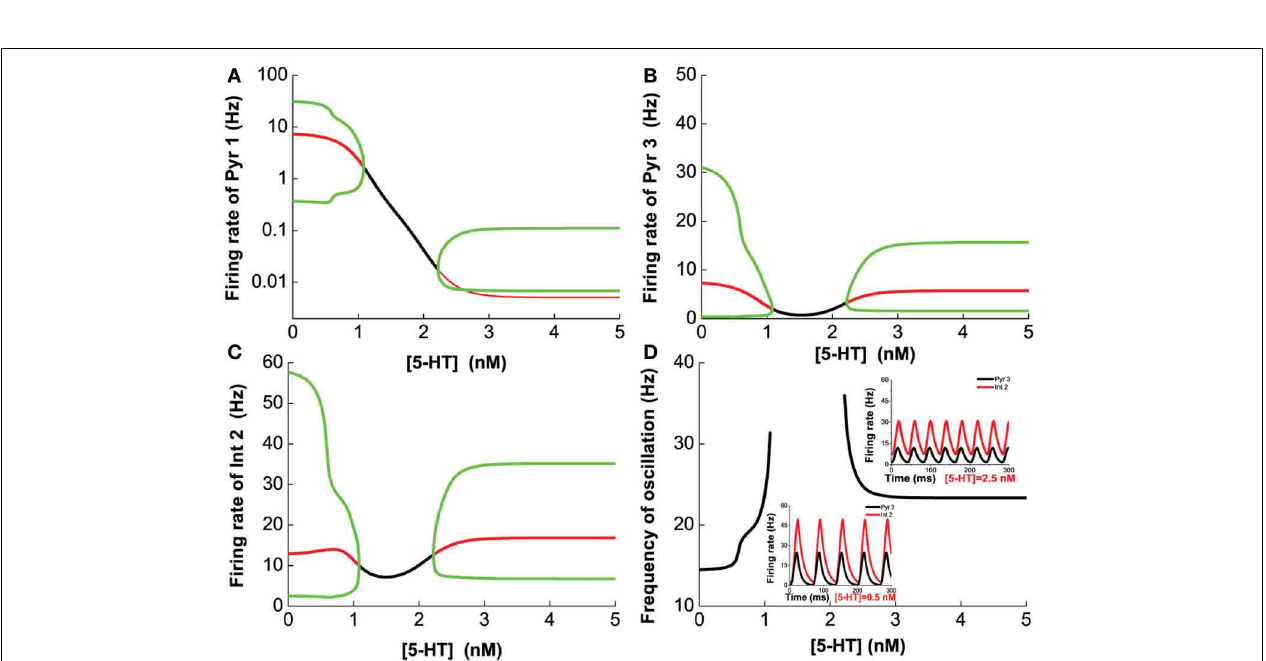
FIGURE 7 | Dependence of the heterogeneous network behavior on [DA]. Oscillation of the network emerges from a Hopf bifurcation at [DA] = 3.21nM. (A–C) The amplitude of the oscillation increases with increasing [DA] before the activation of D2 receptors reduce (A,C) or